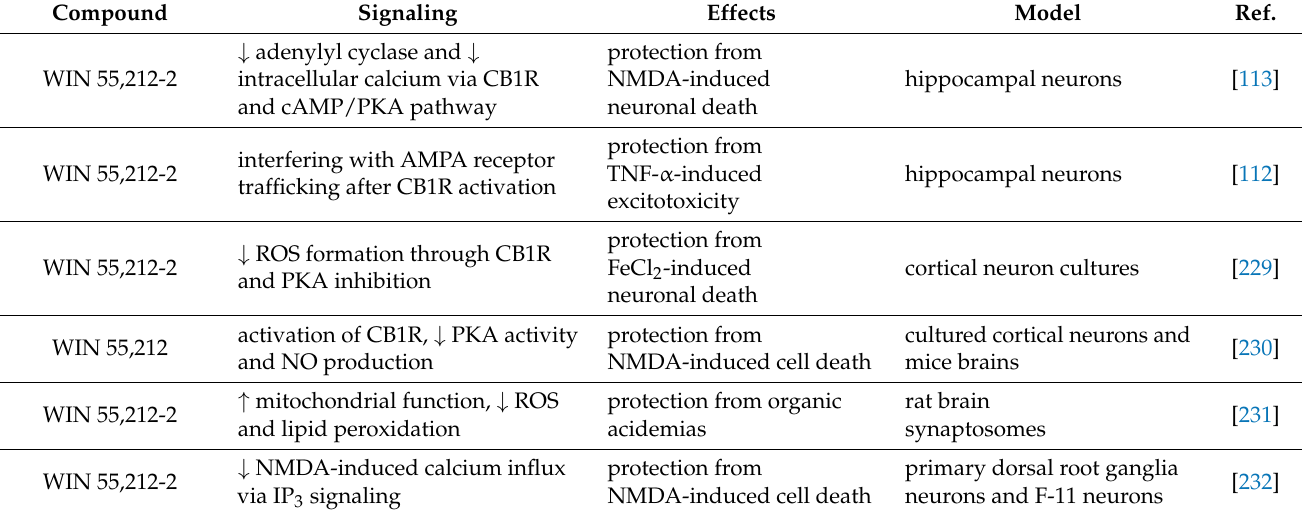
Table 4. Antioxidant and anti-inflammatory effects of synthetic cannabinoids in neurodegenerative